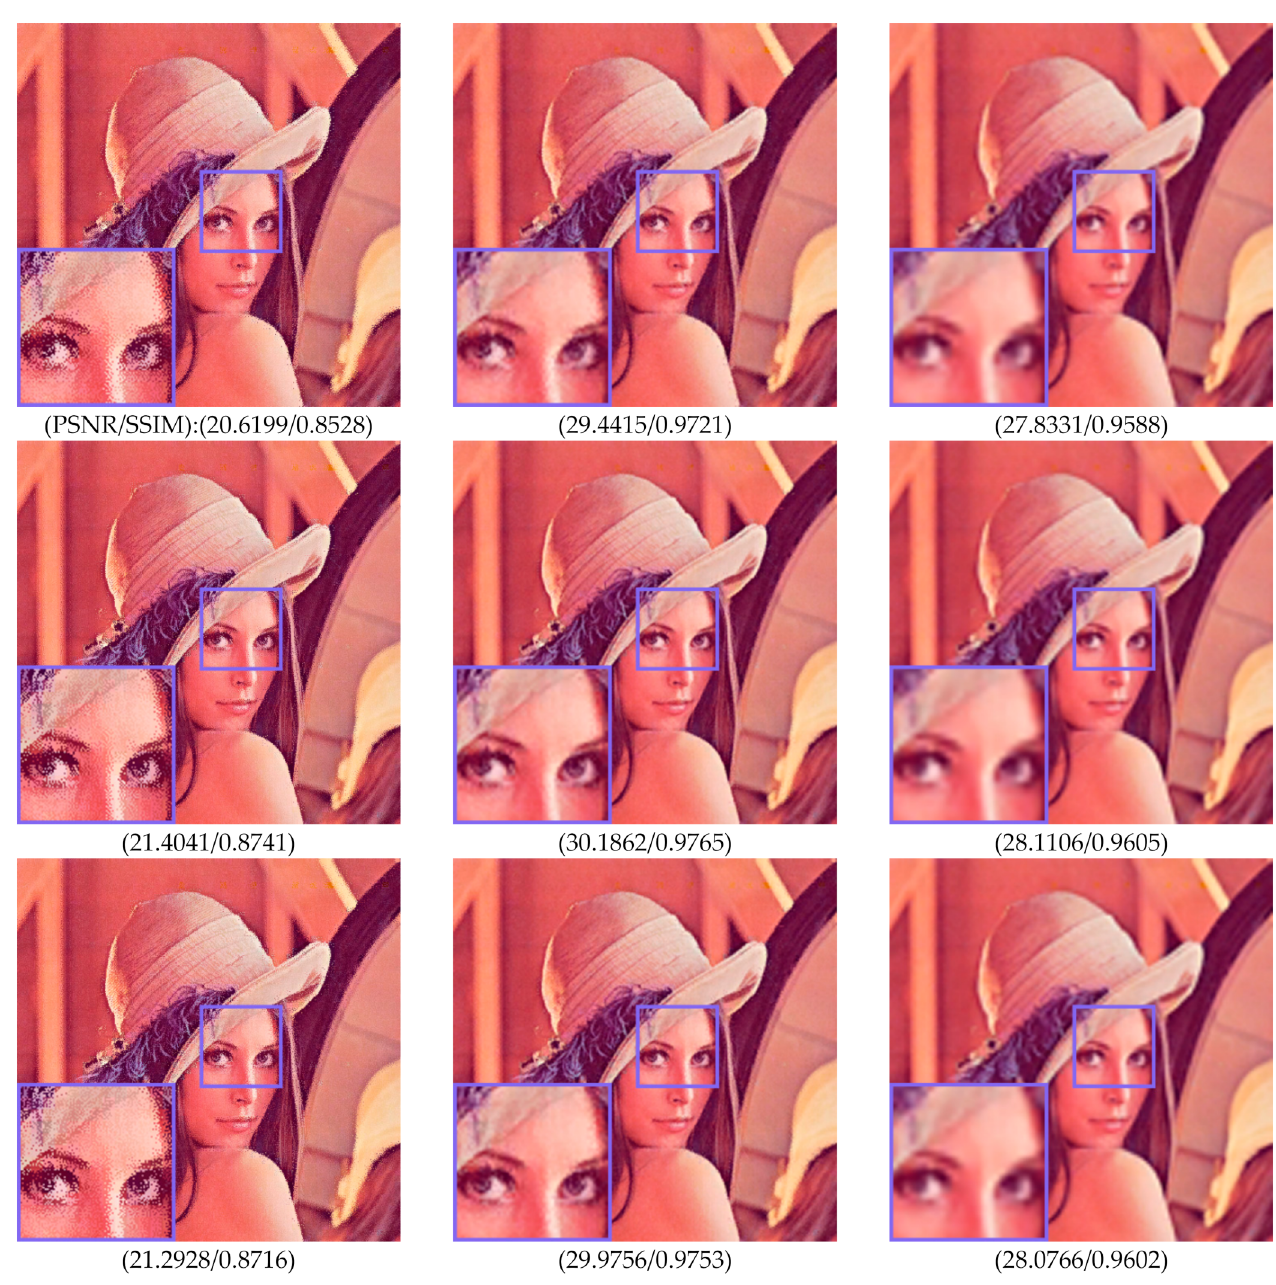
Figure 5. Effects of performing downsampling and upsampling operations on (first to last rows) ODBTC, EDBTC, and DDBTC. The first column is the original decoded image. The second column are reconstructed images after applying downsampling with factor 0.5 and upsampling to the original size, while the third column are images after downsampling operator over factor 0.25 and upsampling to the original